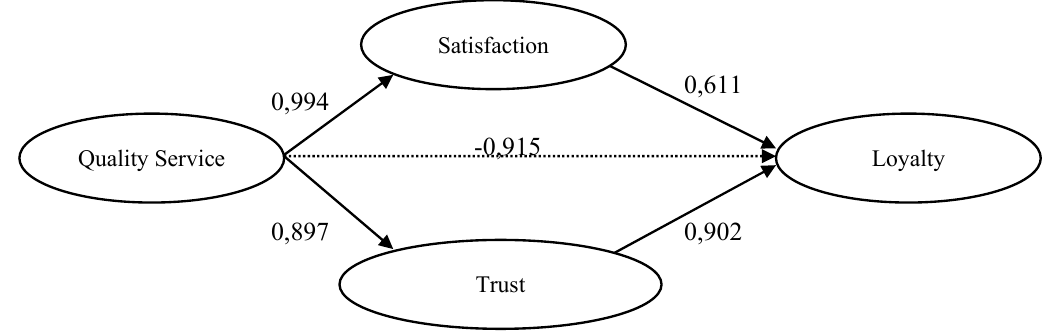
Fig. 3. Causality Model between